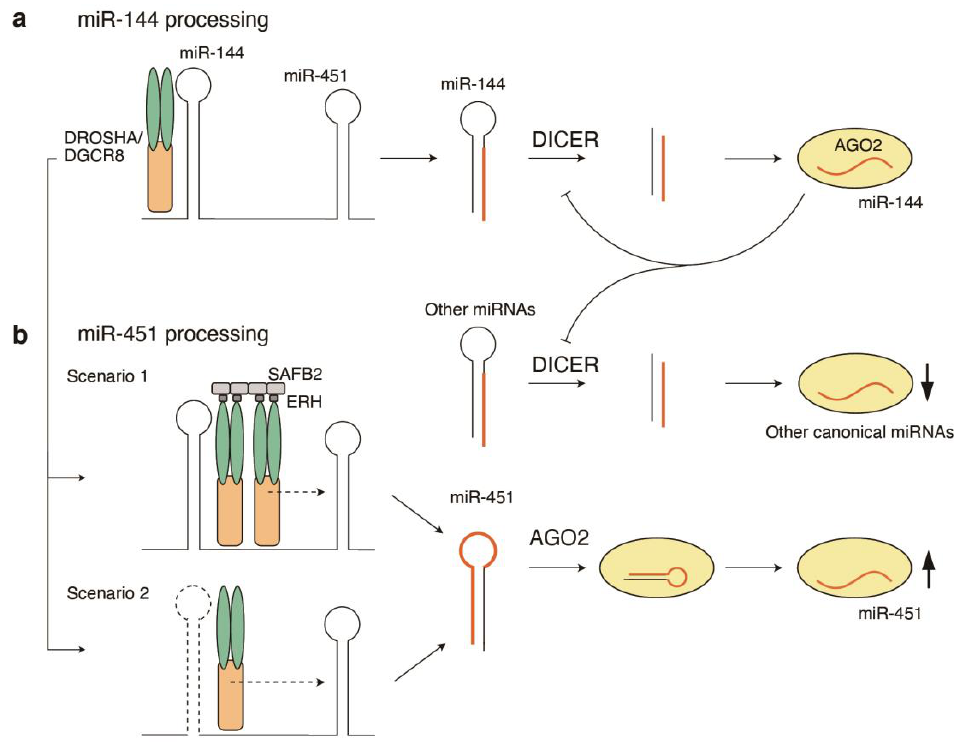
Figure 2. Cluster assistance mechanisms for processing of suboptimal pri-miRNAs. ( a ) The pri-miR- miR-144 recruits DROSHA–DGCR8 and is processed by the canonical pathway. In erythropoiesis, miR-144 represses canonical miRNA biogenesis through DICER suppression, thereby making miR-451 the most abundant miRNA in erythrocytes. ( b ) For the processing of the suboptimal pri-miR-451, several scenarios have been proposed regarding the assistance from the optimal pri-miR-144. Sce-